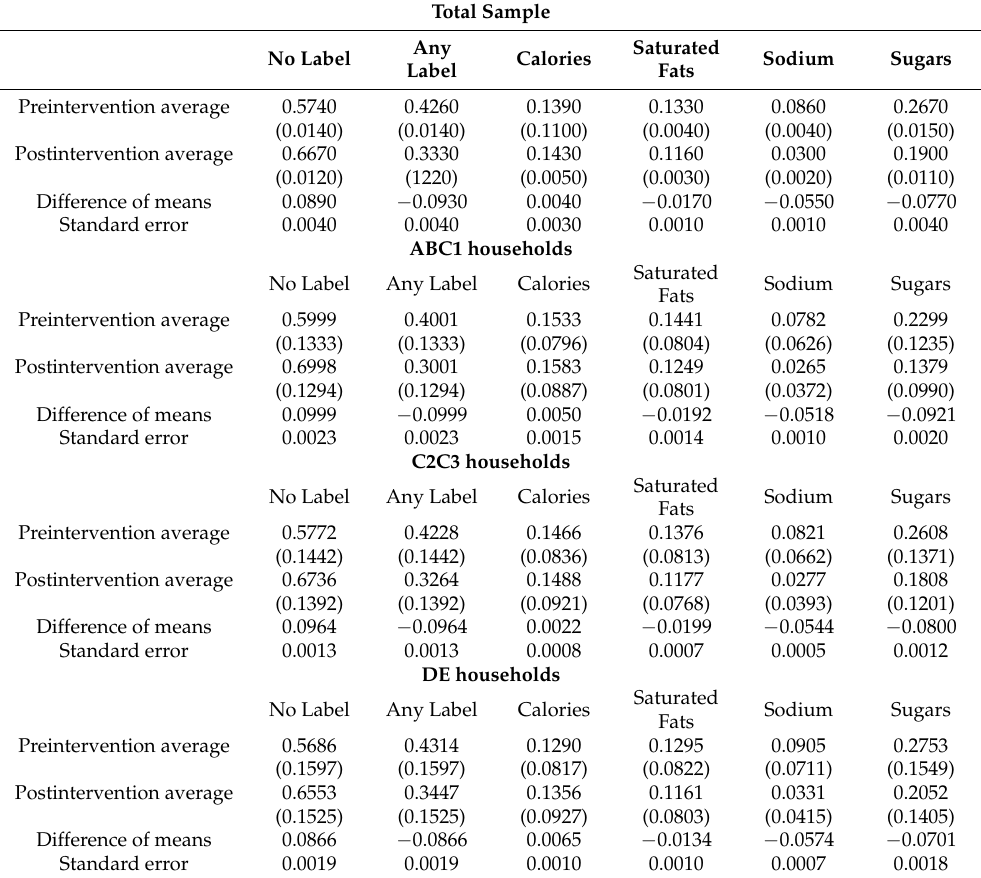
Table 2. Average monthly budget share allocated to labeled products by period and differences of means, total sample, and by SES